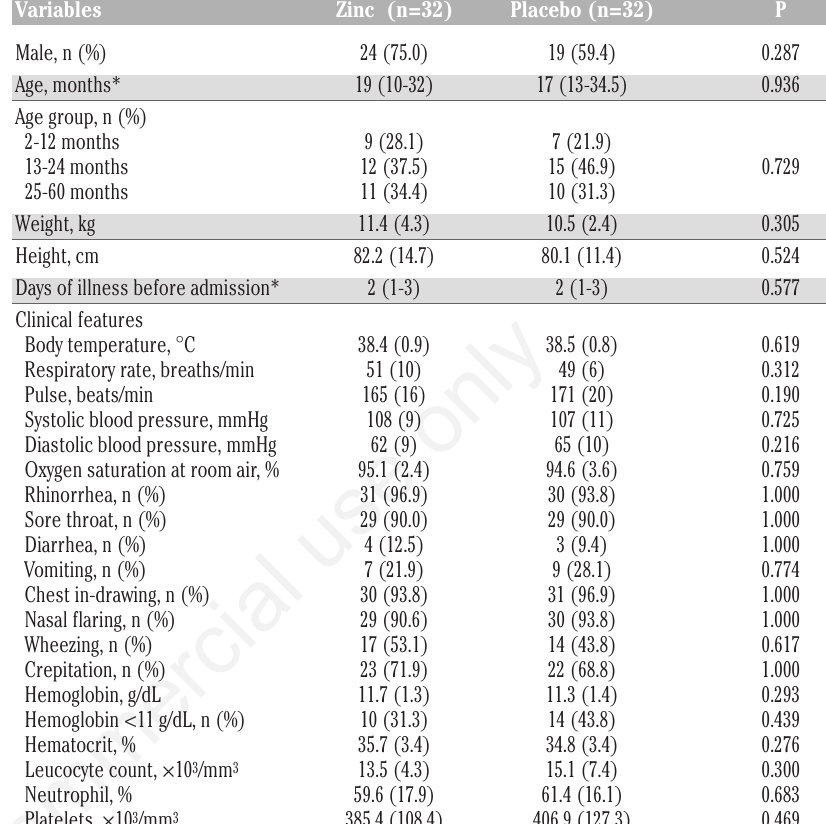
Table 1. Baseline demographic characteristics and clinical features of participants. Variables